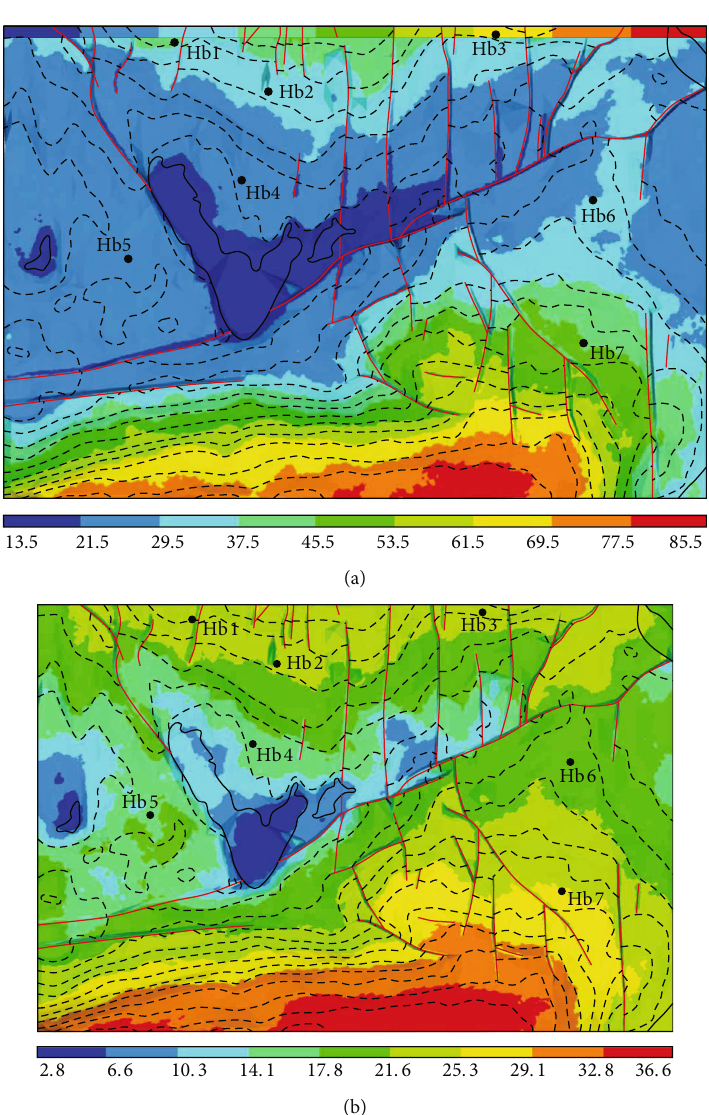
Figure 8: The calculated S (a) and S (b) magnitudes in the Longmaxi Formation of Haiba Block (compressive stresses are Hmax hmin considered as positive and tensile stresses are